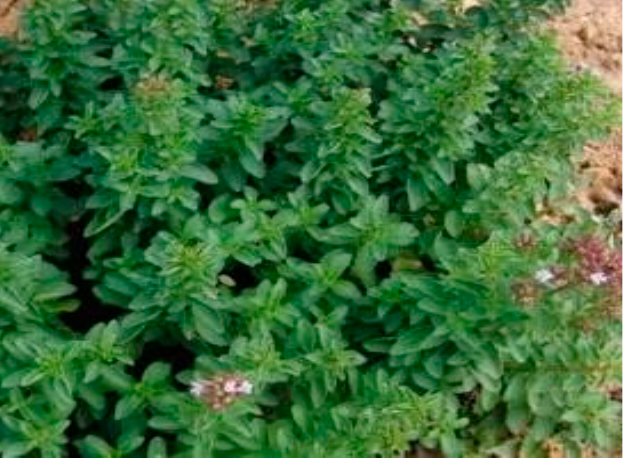
Figure 3. Morphological appearance of O. compactum